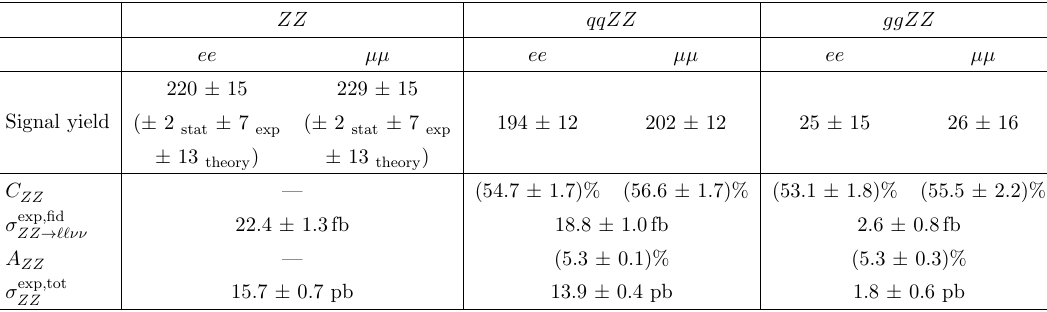
and A coe(cid:14)cients de(cid:12)ned ZZ ZZ